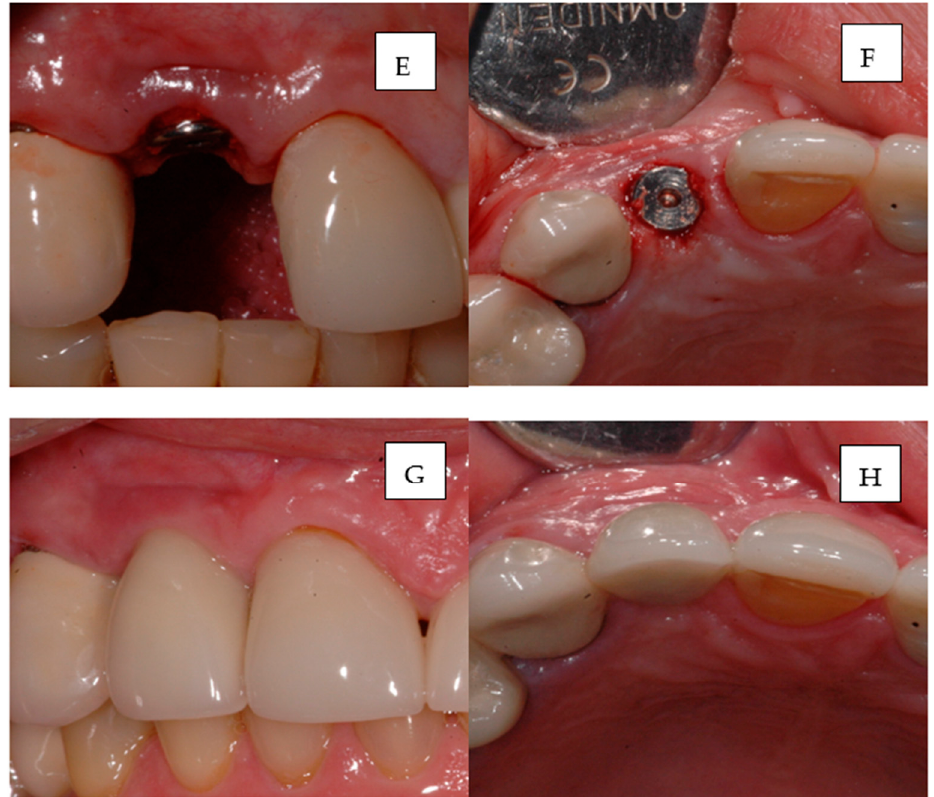
Pharmaceutics 2023 , 15 , 138 14 of 19 Figure 5. Clinical case. bioactive healing abutment (BHA) use for the treatment of 12 peri-implant mucositis. ( A ). Before treatment; ( B ). Crown unscrewed; ( C ). BHA; ( D ). BHA chamber filled with clindamycin. ( E ). BHA fixed on implant, treatment starting point; ( F ) BHA fixed on implant after 2 days. ( G , H ) 2 weeks after treatment with BHA with clindamycin.